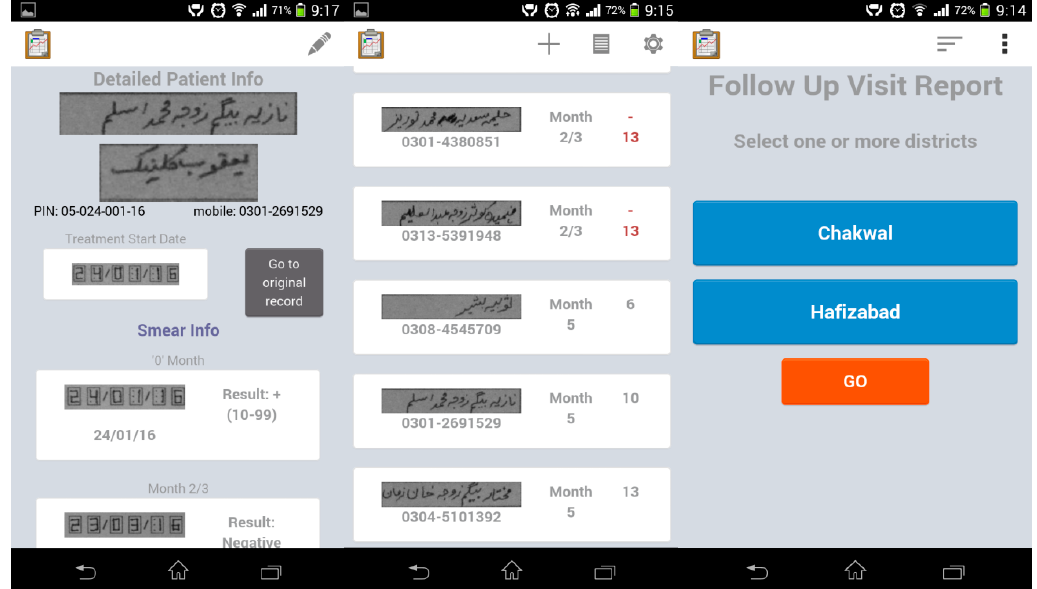
Figure 7. Process of Follow up Visit Report ( left to right )